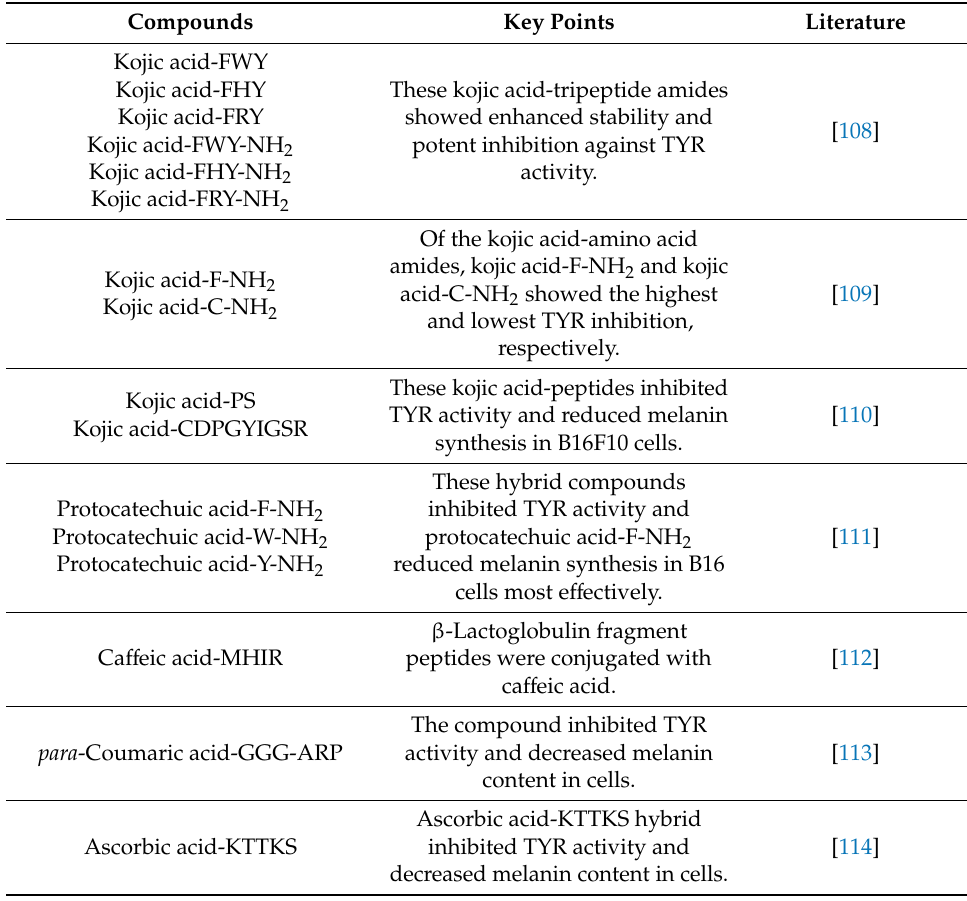
Table 4. TYR inhibitory peptides conjugated with other chemical moieties. Key